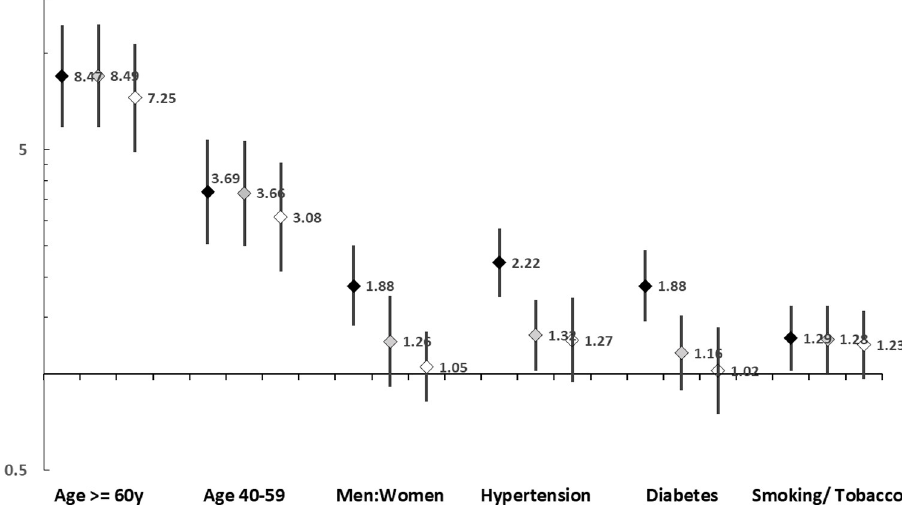
Fig 3. Odds ratio and 95% confidence intervals for COVID-19 related deaths in patients in old vs young, men vs women, hypertension, diabetes and tobacco groups on univariate (black markers), age and sex adjusted (grey markers) and multivariate (open markers) logistic